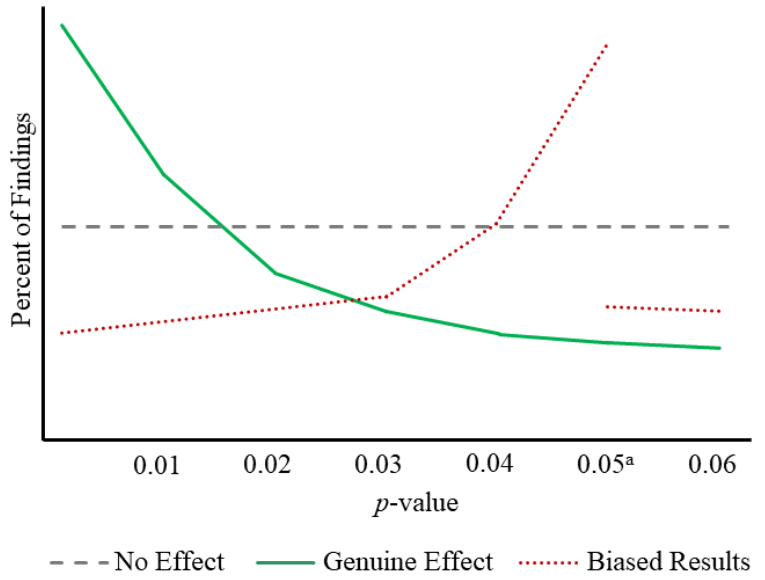
Figure 1. How to visualize bias in p -values. a This could be any pre-determined threshold such as p < 0.01 or 0.001 and result in the same expected patterns. Just that 0.05 happens to be one of the more popular ‘cutoffs’.